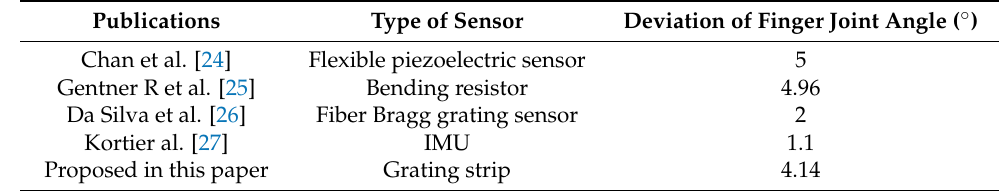
Table 6. Comparison of proposed finger joint angle measurement solution and others